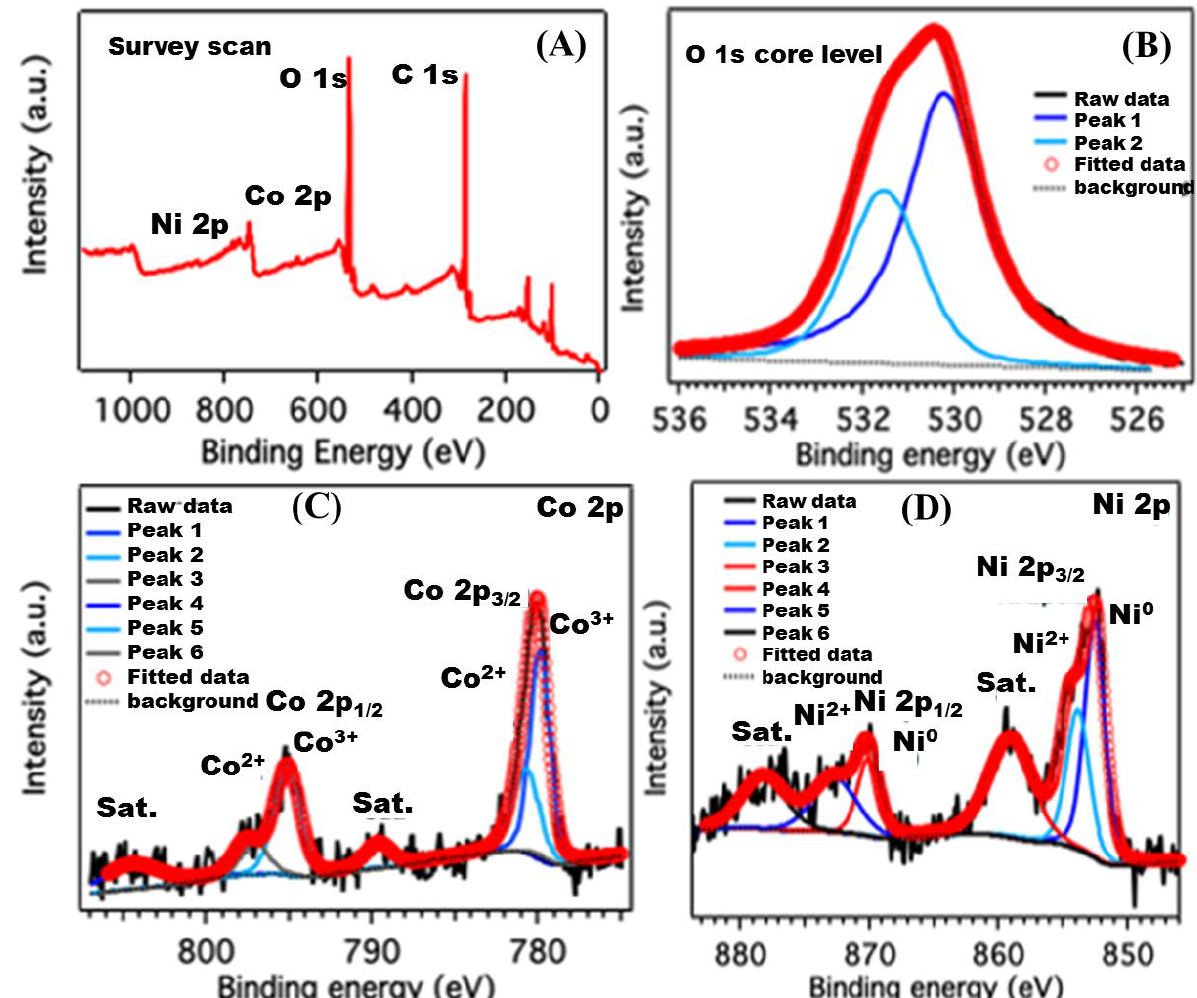
Figure 3. ( A ) Core-level XPS survey spectrum for NiCo(OH) 2 -LDH. The fitted and de-convoluted high-resolution XPS spectra of ( B ) oxygen are referred to as O (1s), for ( C ) cobalt are referred to as Co (2p), and for ( D ) nickel are referred to as Ni(2p).